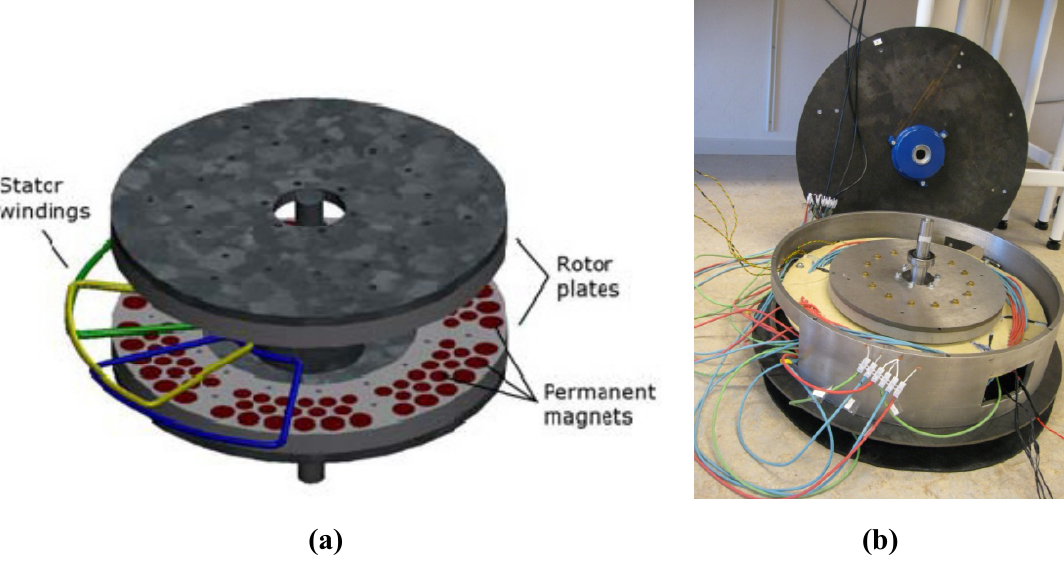
Figure 2. ( a ) Drawing of the inner part of the axial flux machine under investigation. The complete structure was enclosed in a cylindrical vacuum chamber; ( b ) Picture of